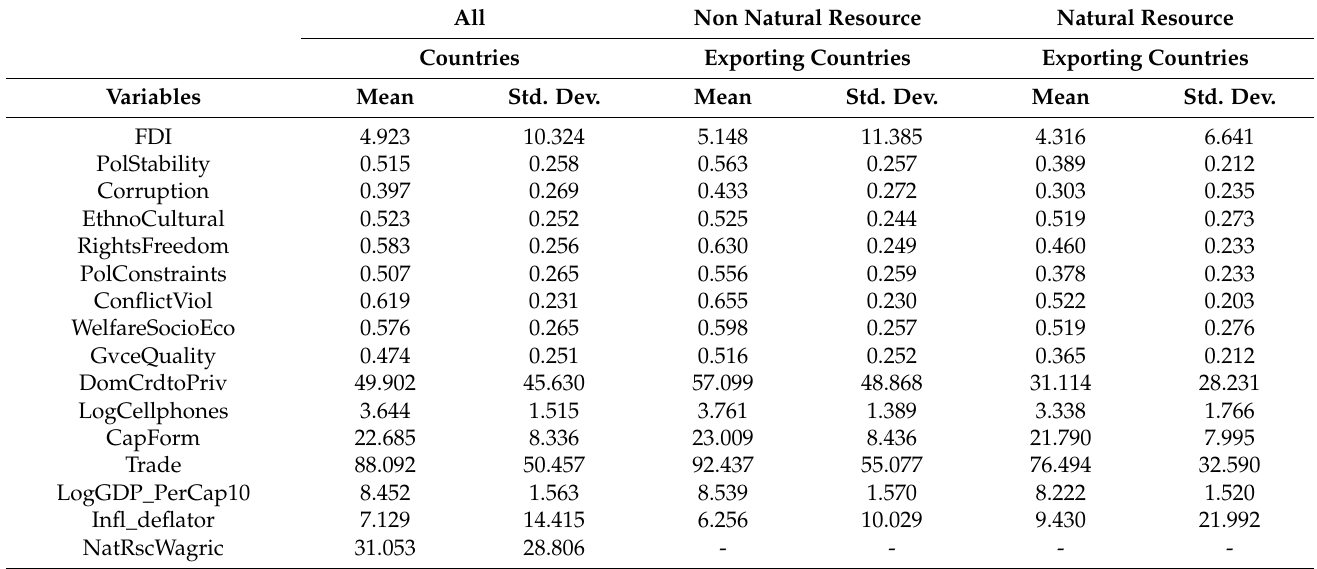
Table 1. Summary